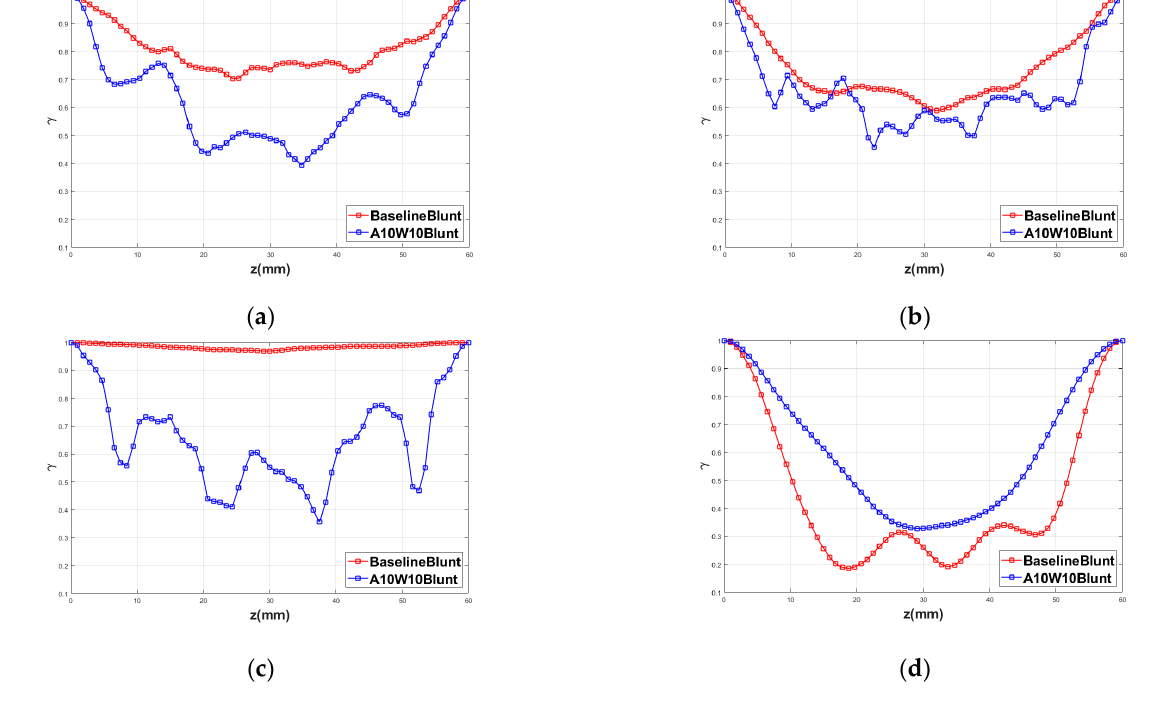
Figure 20. Spanwise coherence analysis of the pressure fluctuations at various frequencies: ( a ) f = 2050.8 Hz; ( b ) f = 3515.6 Hz; ( c ) f = 4687.5 Hz; ( d ) f = 14,550.8 Hz.